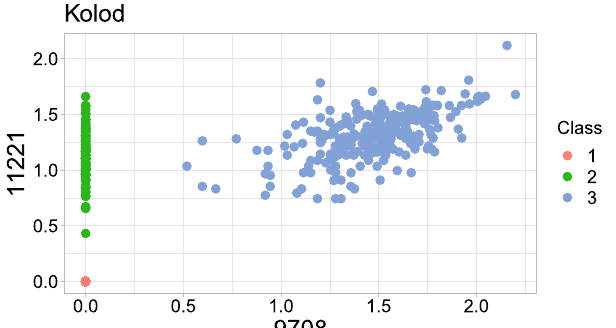
Figure 4. Scatter plot of the first two (the 9708th and 11221st) critical cell gene expressions for the Kolod dataset.